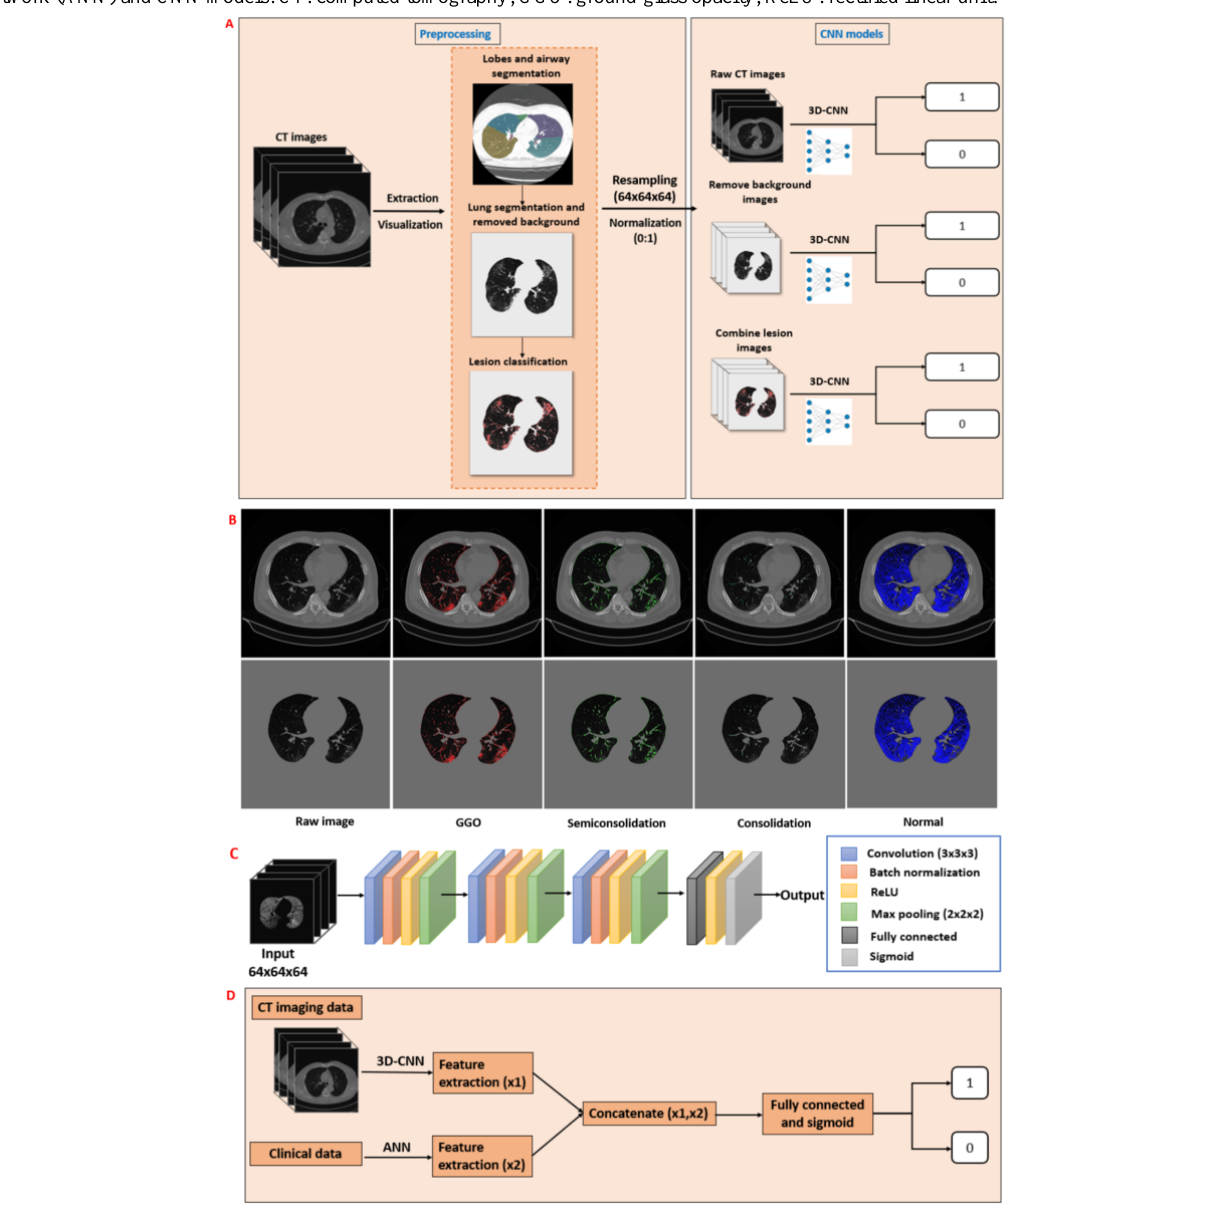
Figure 2. Main experimental products of (A) convolutional neural network (CNN) models, (B) lung lesion segmentation parts of a severe subject, (C) the architecture of our CNN model, and (D) illustration of the artificial convolutional neural network (ACNN) model, a mix of the artificial neural network (ANN) and CNN models. CT: computed tomography; GGO: ground-glass opacity; ReLU: rectified linear